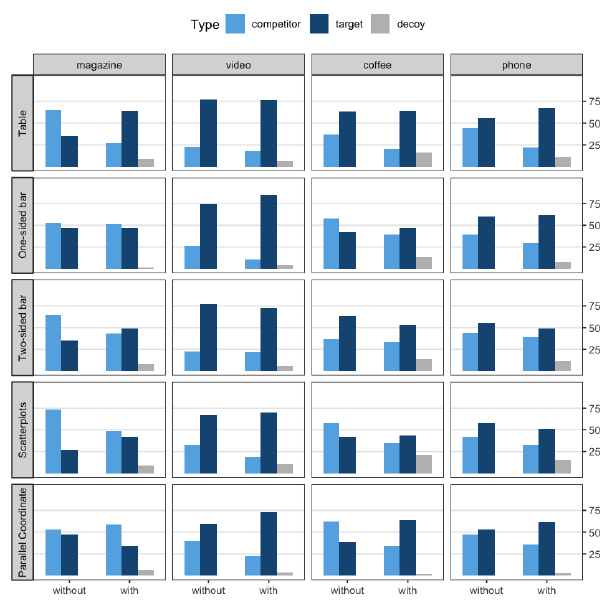
Figure 6. Percentage of selection of each option across all scenarios and